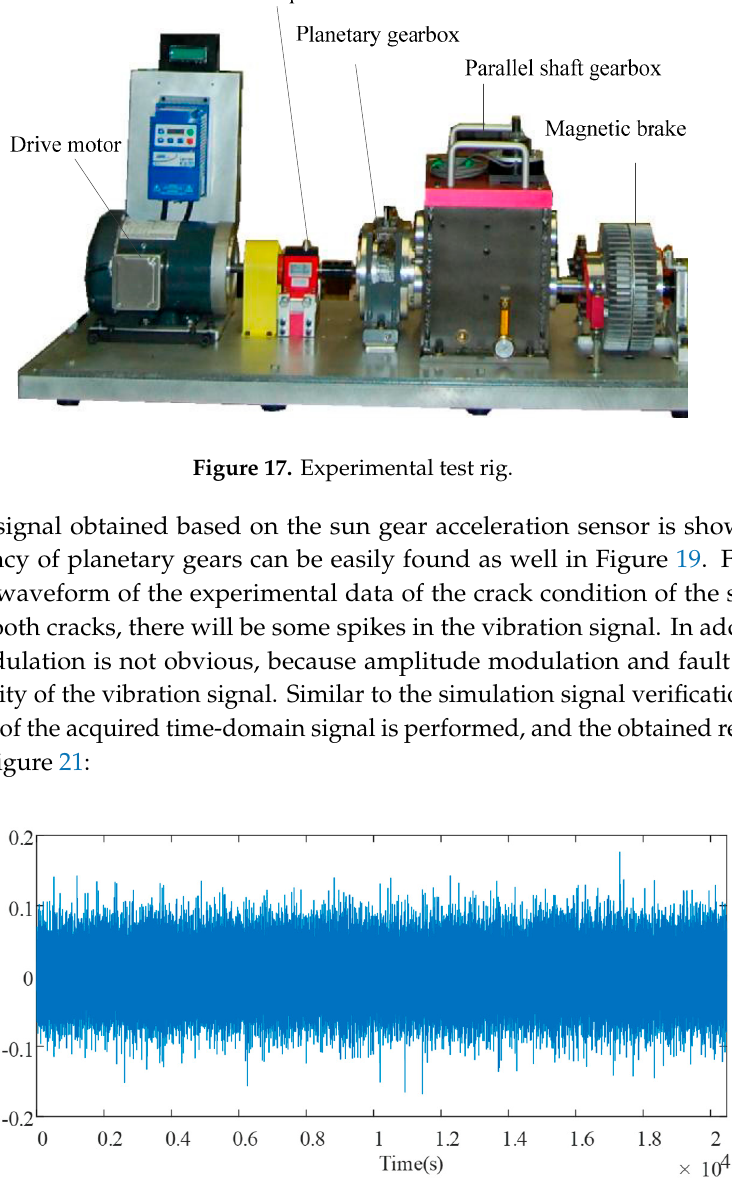
Figure 19. Test signal spectrum in the healthy condition. 0